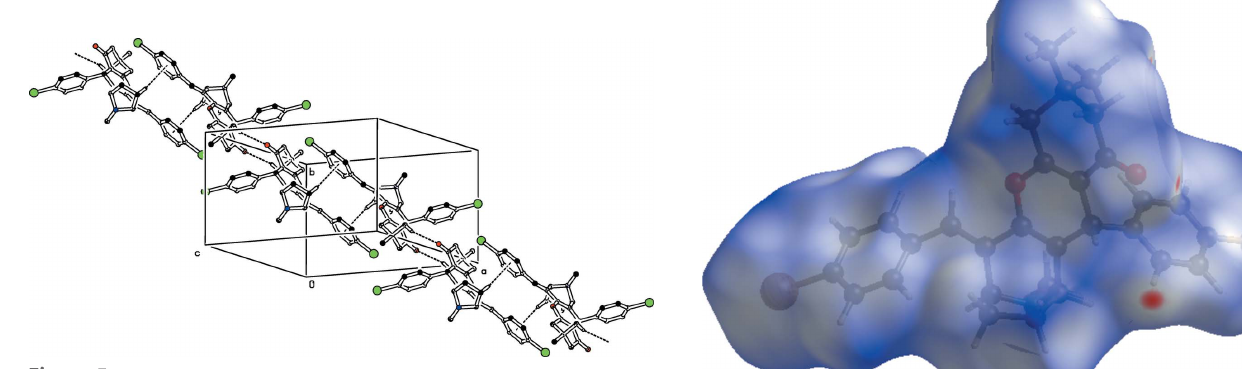
Figure 5 The centrosymmetrical dimer formed in compound (II) via C—H (cid:2)(cid:2)(cid:2) O hydrogen bonds (dashed lines). The dimers are linked by C—H (cid:2)(cid:2)(cid:2) (cid:2) interactions (dashed lines). For clarity H atoms, not involved in these interactions have been omitted.